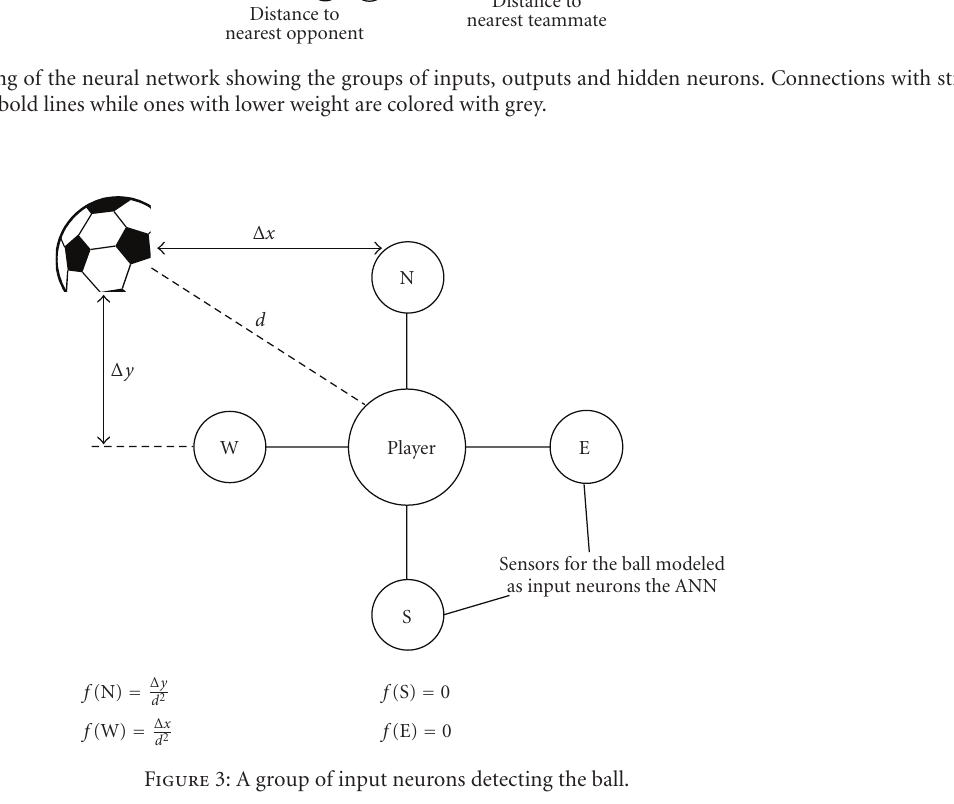
Figure 3: A group of input neurons detecting the ball.